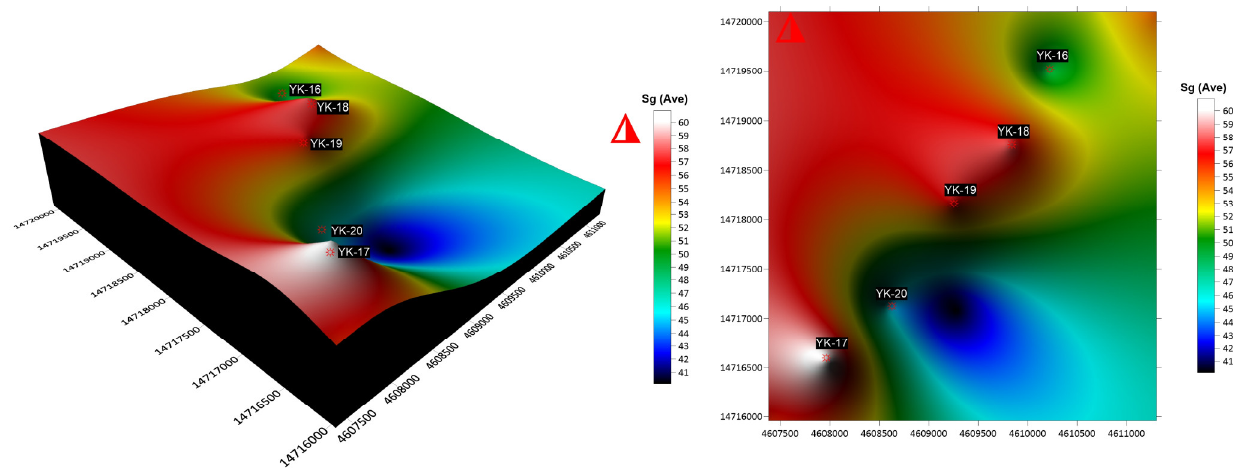
Figure 15. Gas saturation (Sg) map (calculated in %).